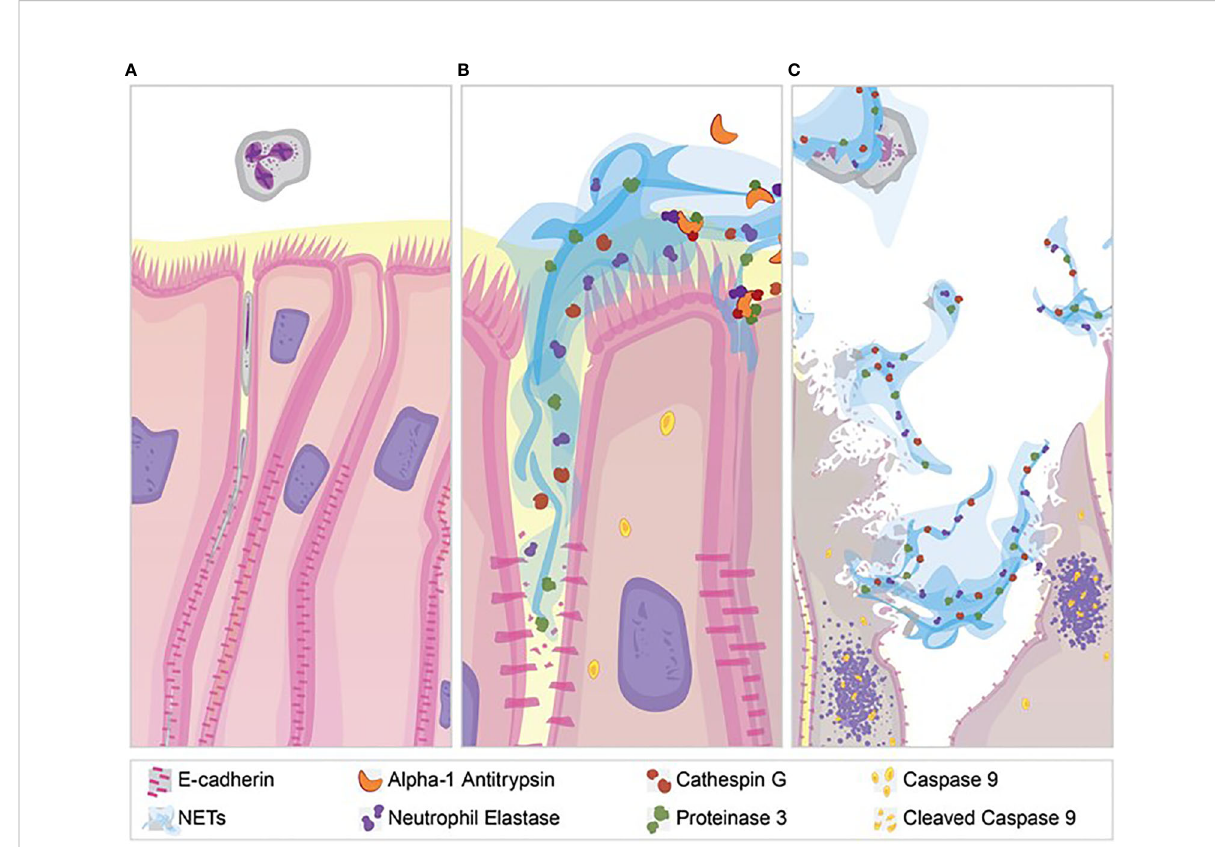
FIGURE 8 NET effect on bronchial epithelial barrier function. (A) Pseudostrati fi ed bronchial epithelia form a monolayer with cell-cell contact via junctional proteins. This epithelial barrier tightly controls the paracellular fl ux of molecules and cells. (B) Neutrophils expel NETs, which contain biologically active proteases that degrade adherens junction protein E-cadherin creating gaps in the monolayer. A1AT limits NET degradation of E-cadherin to help restore barrier function. (C) NETs also disrupt barrier function by causing epithelial cell death via apoptosis, which is limited by